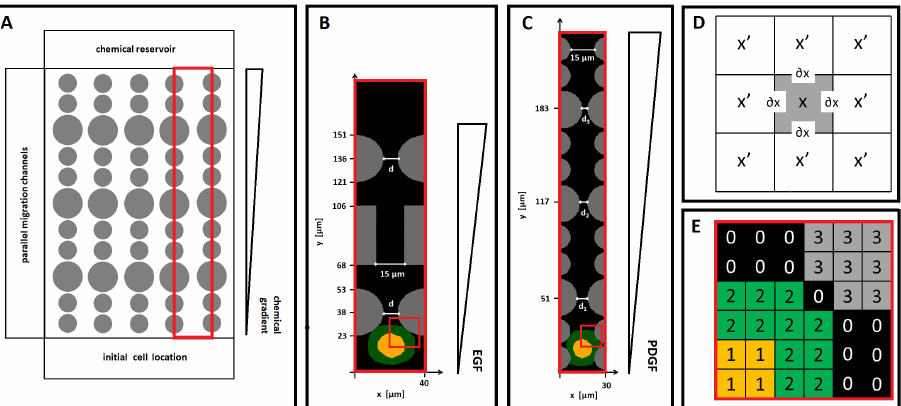
Figure 1. ( A ) Schematic representation of the microfluidic devices proposed in [18,19]. ( B ) Simulation domain Ω replicating a representative channel of the migration device employed in [19]. ( C ) Simula- tion domain Ω reproducing a representative migratory channel of the migration device employed in [18]. ( D ) Portion of a 2D Cellular Potts model (CPM) lattice with a generic lattice site x , its border ∂ x , and its first-nearest neighbors x (cid:48) . ( E ) The virtual cell is compartmentalized into a central nuclear cluster, the object Σ 1 of type N (in yellow), and in the surrounding cytosolic region, the element Σ 2 of type C (in green). The rigid pillars are reproduced by CPM objects Σ σ ≥ 3 of type P (in gray). The rest of the domain is formed by an extended undifferentiated element Σ 0 of type M (in